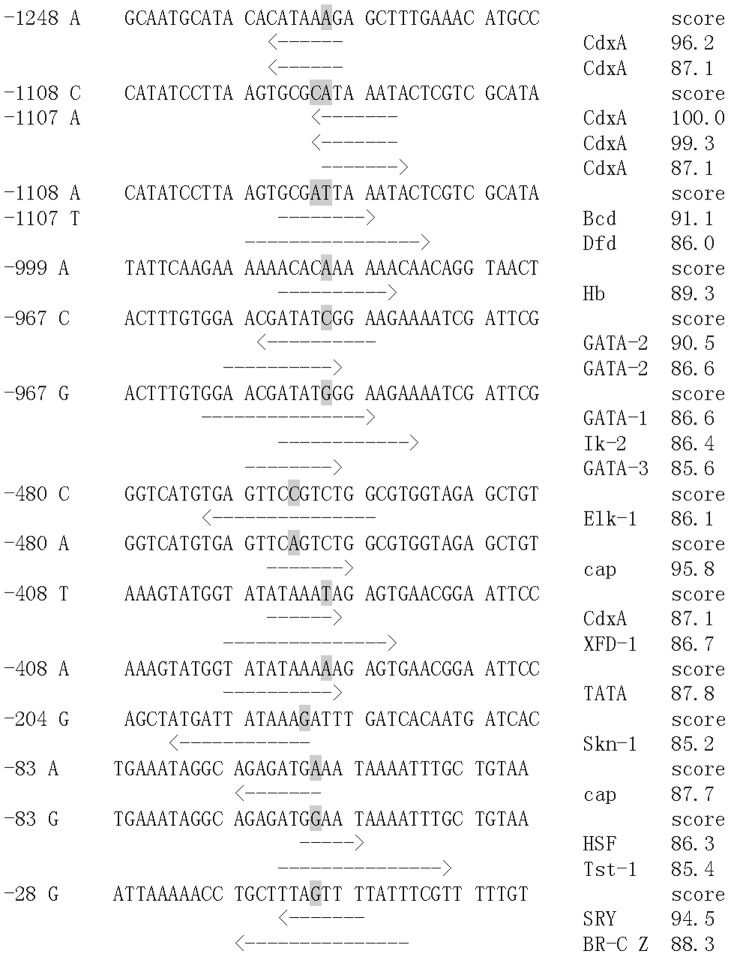
Difference of putative binding sites for transcription factors between different alleles.Polymorphic loci are shadowed in gray and the first polymorphic locus of each line is numbered on the left. The positions and directions of putative binding sites for transcription factors are labeled by arrowhead. The TFSEARCH scores are shown on the right.